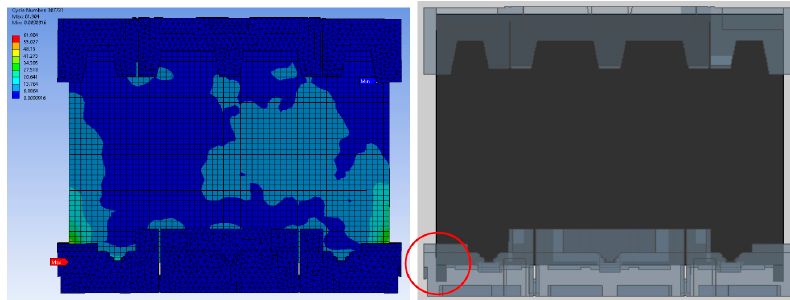
Figure 9. Analysis result of model A.